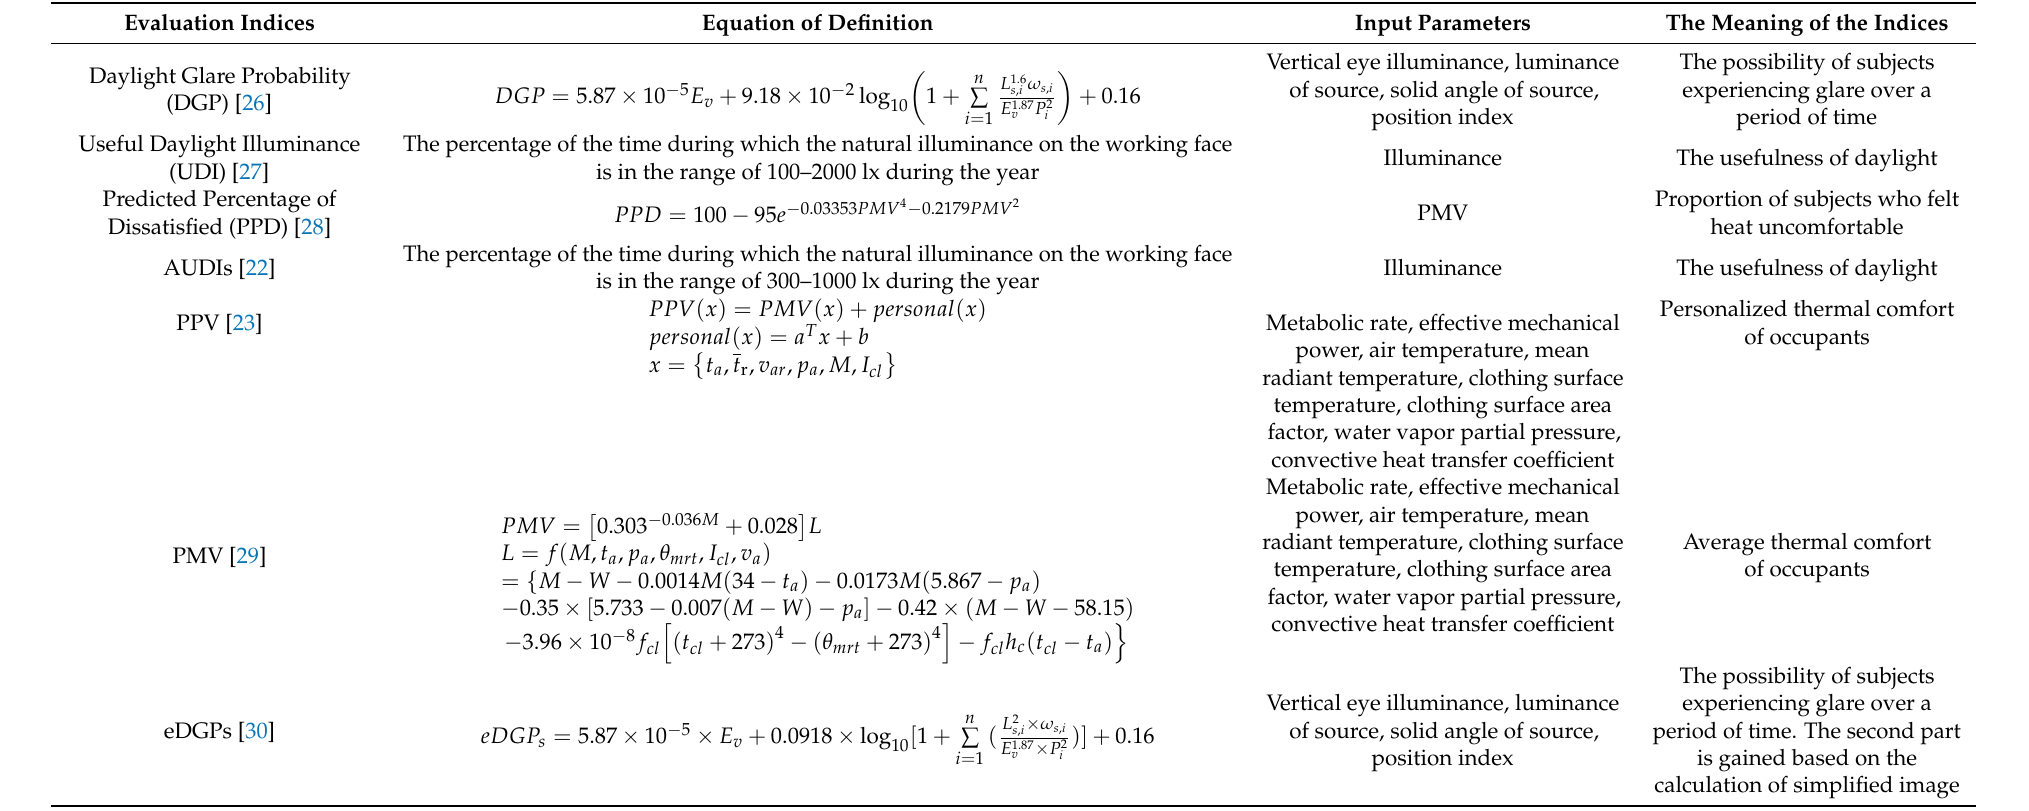
Table 2. Current mainstream evaluation indices for various